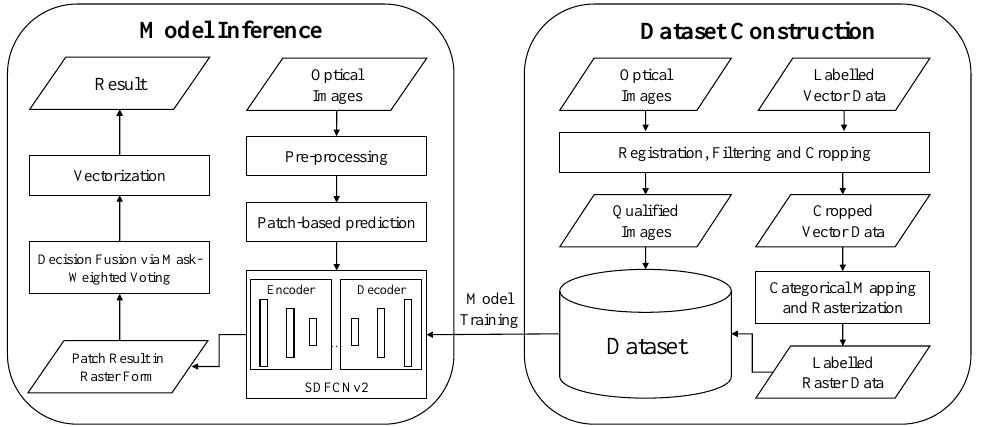
Figure 10. Our proposed SDFCNv2 framework. It includes constructing training datasets from original RS images with labelled vector data, model training and model inference process.